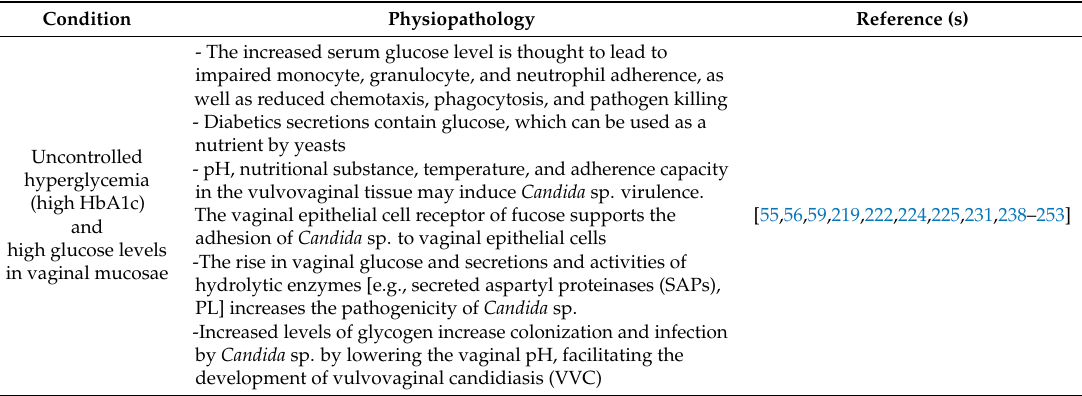
Table 2. Physiopathology and etiology related to the occurrence of vulvovaginitis in